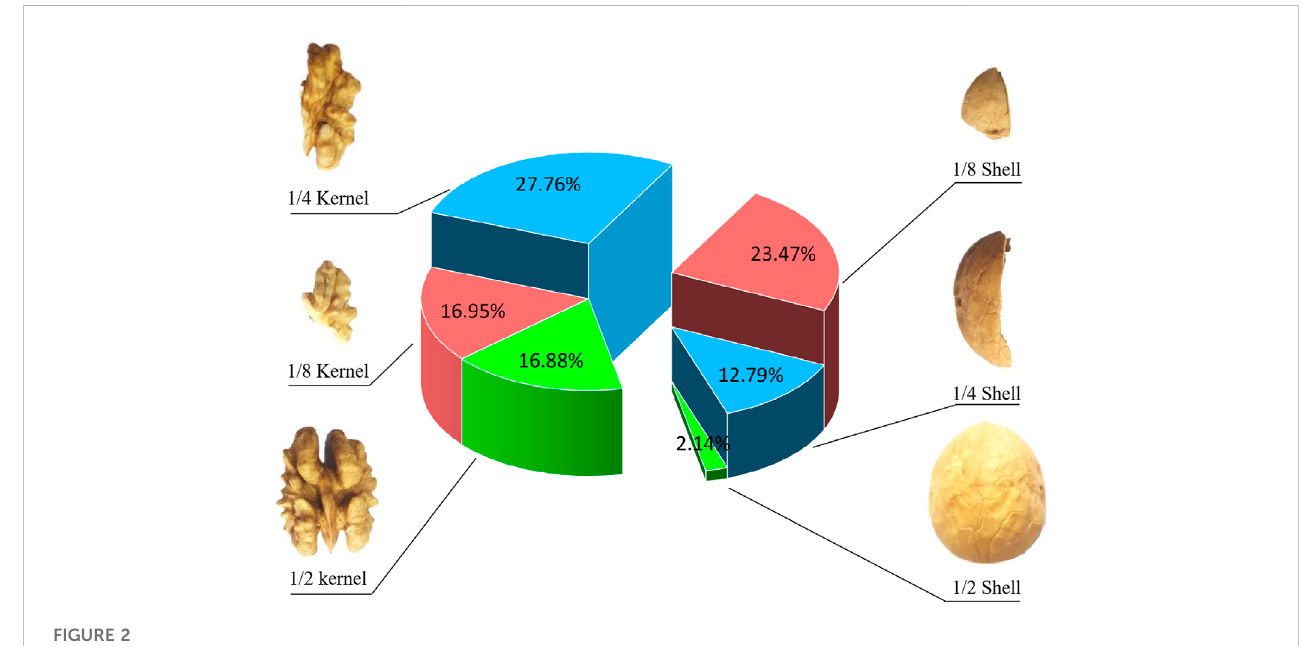
FIGURE 2 Component proportion diagram of shell-kernel